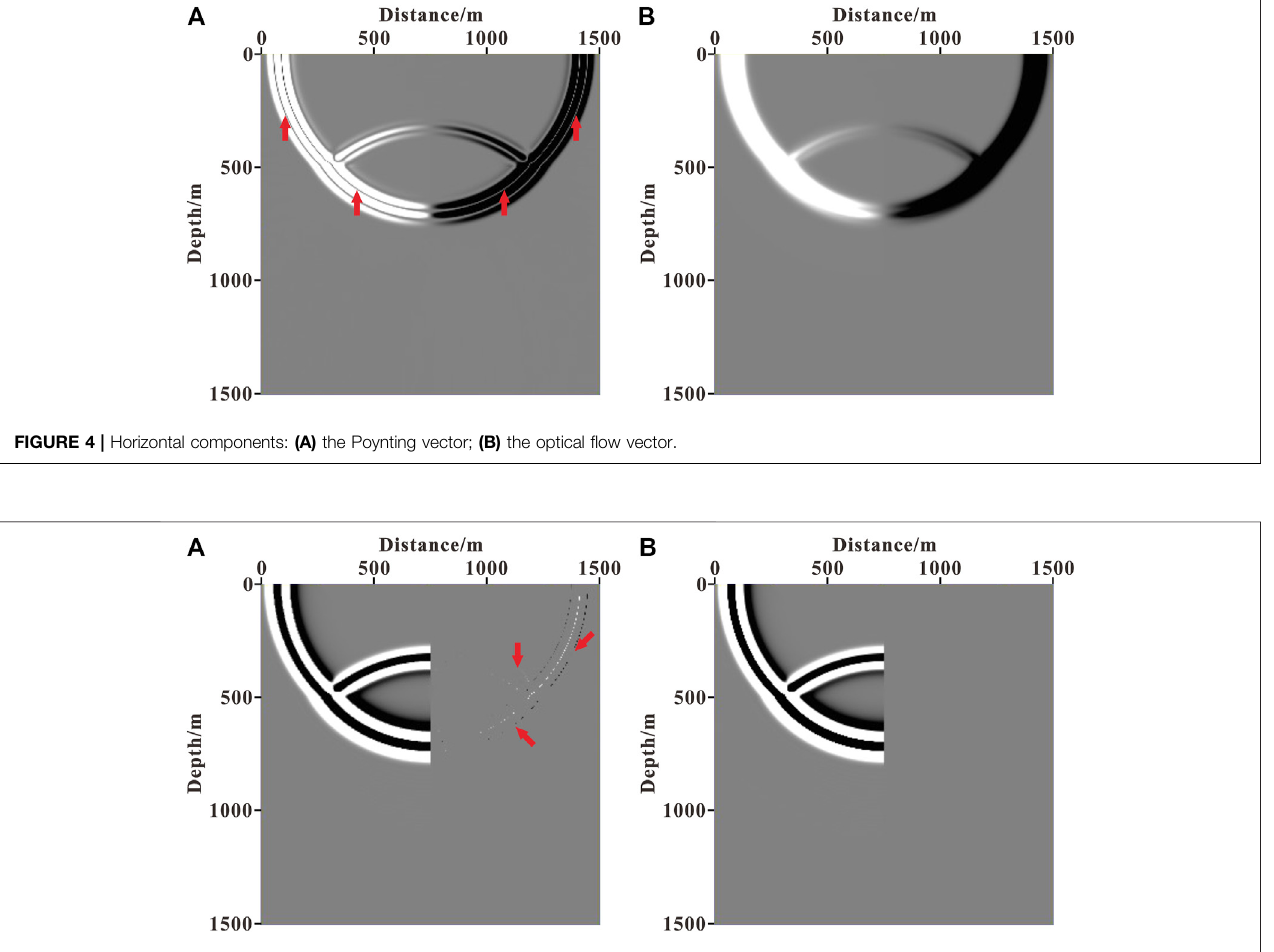
FIGURE 5 | Left-going wave fi eld after decomposition: (A) based on the Poynting vector; (B) based on optical fl ow vector.